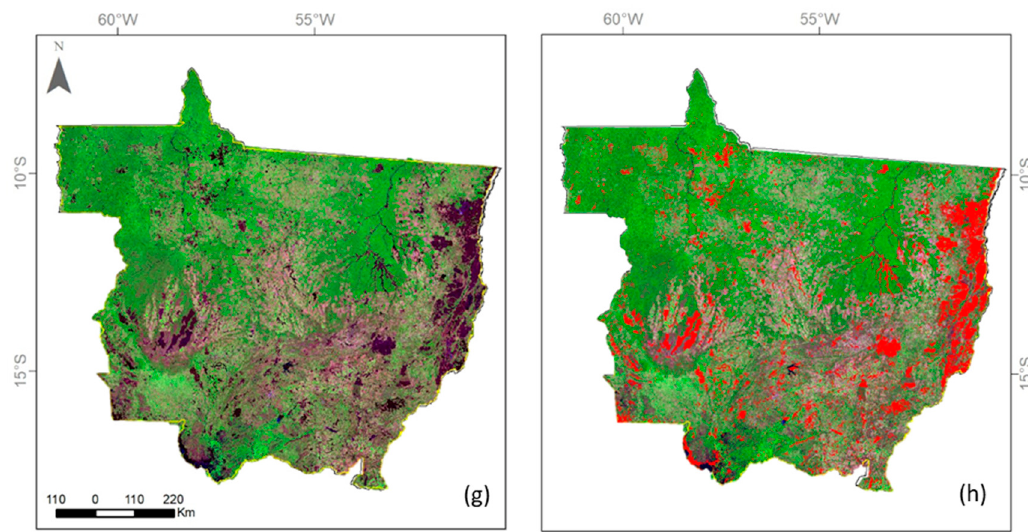
Figure 5. ( a ) Landsat OLI mosaic (August and November 2015); ( b ) burned areas over the mosaic showed in ( a ), showing the correspondence with dark areas; ( c ) PROBA-V mosaic composed of the pixel with high shade fraction value; ( d ) burned areas over the image in ( c ), showing the correspondence with dark areas; ( e ) VIIRS mosaic composed of the pixel with high shade fraction value; ( f ) burned areas over the image in ( e ), showing the correspondence with dark areas; ( g ) RGB Landsat OLI mosaic composite with the burned areas observed in the OLI, PROBA-V, and VIIRS images analyzed; and ( h ) burned areas over the mosaic showed in ( g ), showing the correspondence with dark areas.